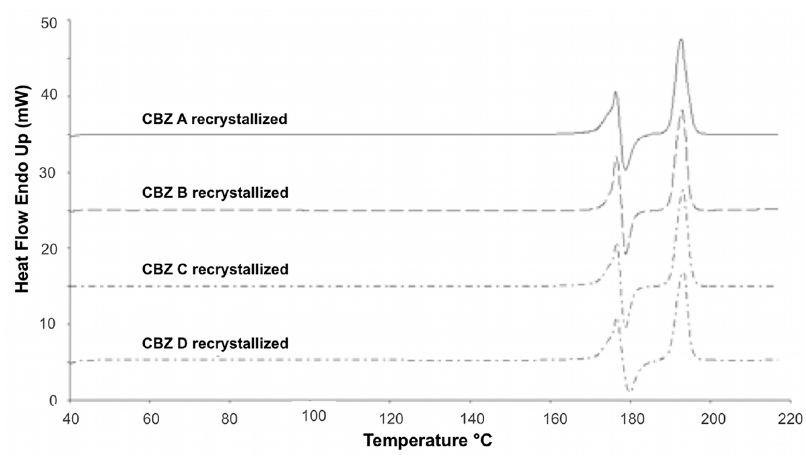
Figure 3. DSC profiles of recrystallized CBZ samples; 10 °C/min scanning rate.